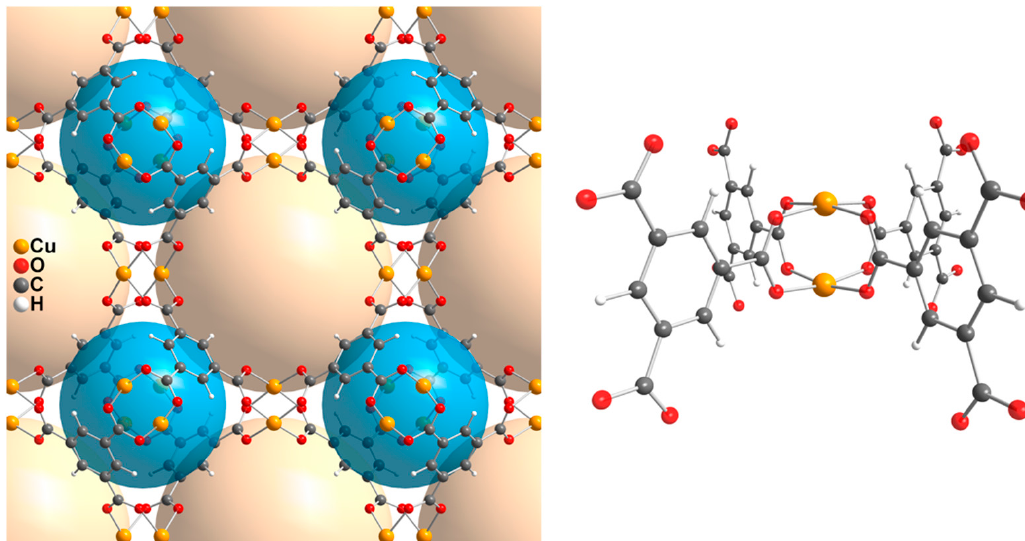
Figure 2. Crystal structure of {Cu 3 (BTC) 2 } n (HKUST-1): (left panel) unit-cell content with large and small cavities highlighted by ochre and blue spheres, respectively; (right panel) paddlewheel model system for the QM/ELMO calculations.